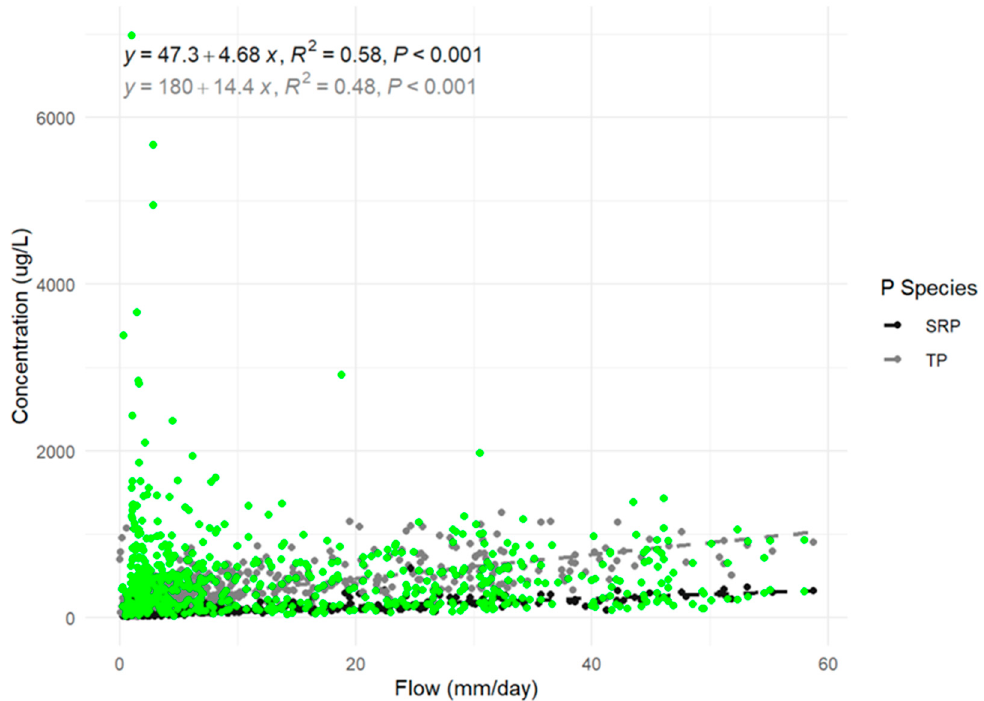
Figure 2. Event TP and SRP concentrations as a function of TD flow rate. Regressions were performed after removing the points in green, i.e., samples taken within the first 10 h of events.